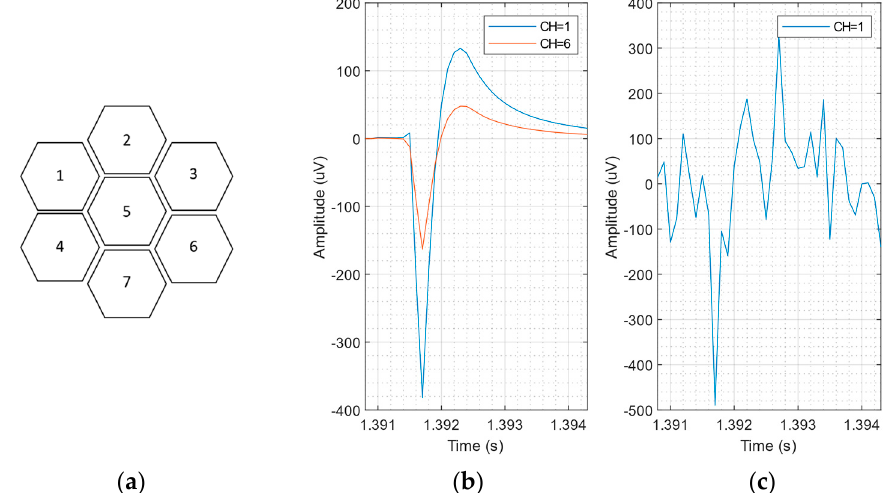
Figure 1. ( a ) The 7-honeycomb sensor pattern ( b ) signals detected by pixel #1 and pixel #6, for a neuron positioned on the west side of the sensor (in the absence of interference and noise). ( c ) Synthetic neural recording with SNR = 3 dB, adding white noise on a noiseless synthetic recording.